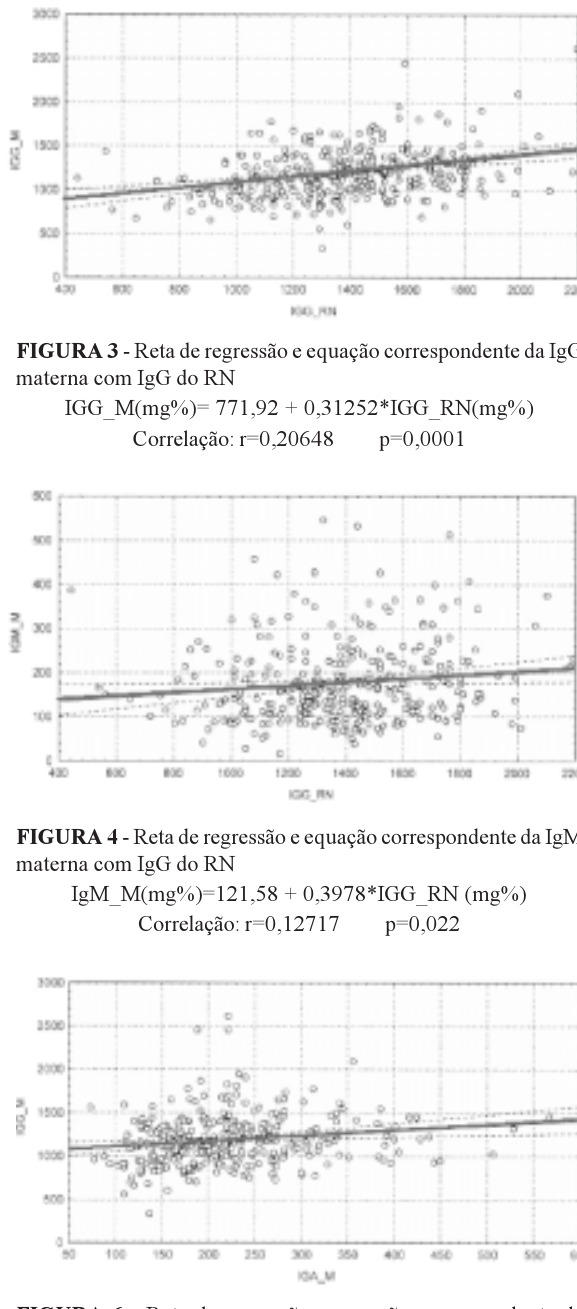
FIGURA 5 - Reta de regressªo e equa(cid:231)ªo correspondente da rela(cid:231)ªo IgA materna com IgG do RN